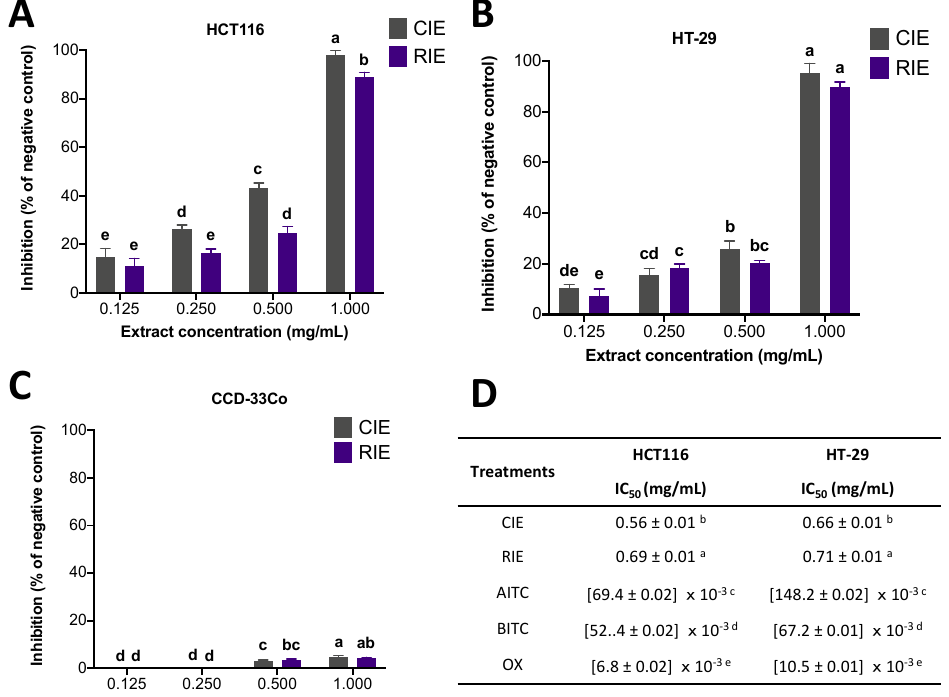
Figure 2. Evaluation of metabolic activity (MTS) in cells treated with CIE, RIE, AITC, BITC, and oxaliplatin (OX) treatments. Effect of CIE and RIE treatments on the metabolic activity inhibition of ( A ) HCT116, ( B ) HT-29, and ( C ) CCD-33Co cells. ( D ) Calculation of half-inhibitory concentrations (IC 50 , mg/mL) of the treatments on HCT116 and HT-29 cells. The results are expressed as the mean ± SD of three independent experiments in triplicate. Different letters indicate significant differences ( p < 0.05) by the Tukey–Kramer test for each concentration ( A – C ) or between treatments ( D ).